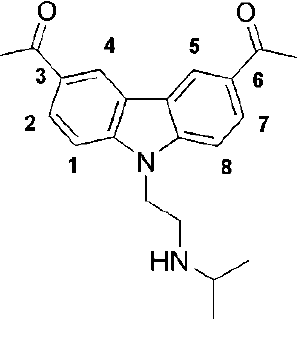
Figure 1. Structure of curaxin CBL0137.